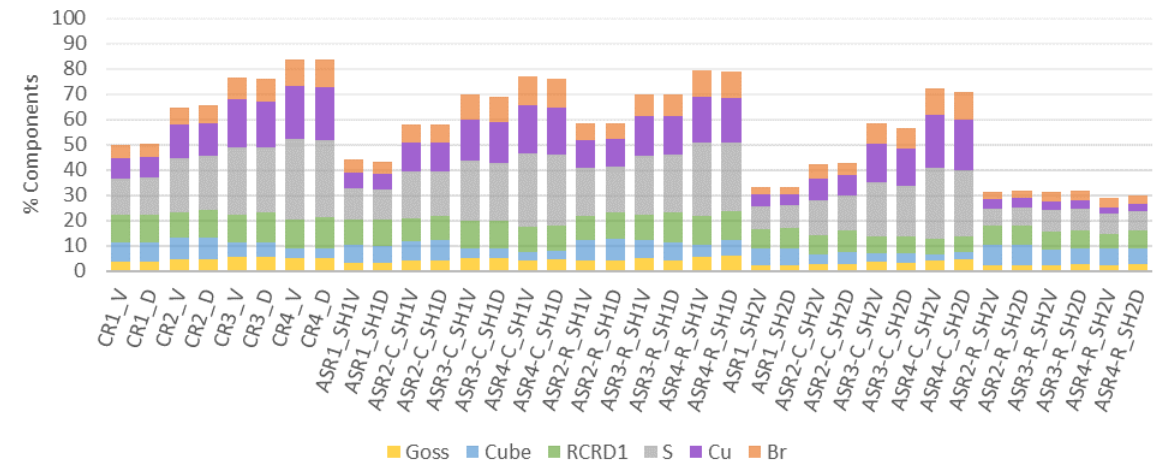
Figure 15. VPSC texture rolling components for four-pass sequences with 20% reduction per pass.